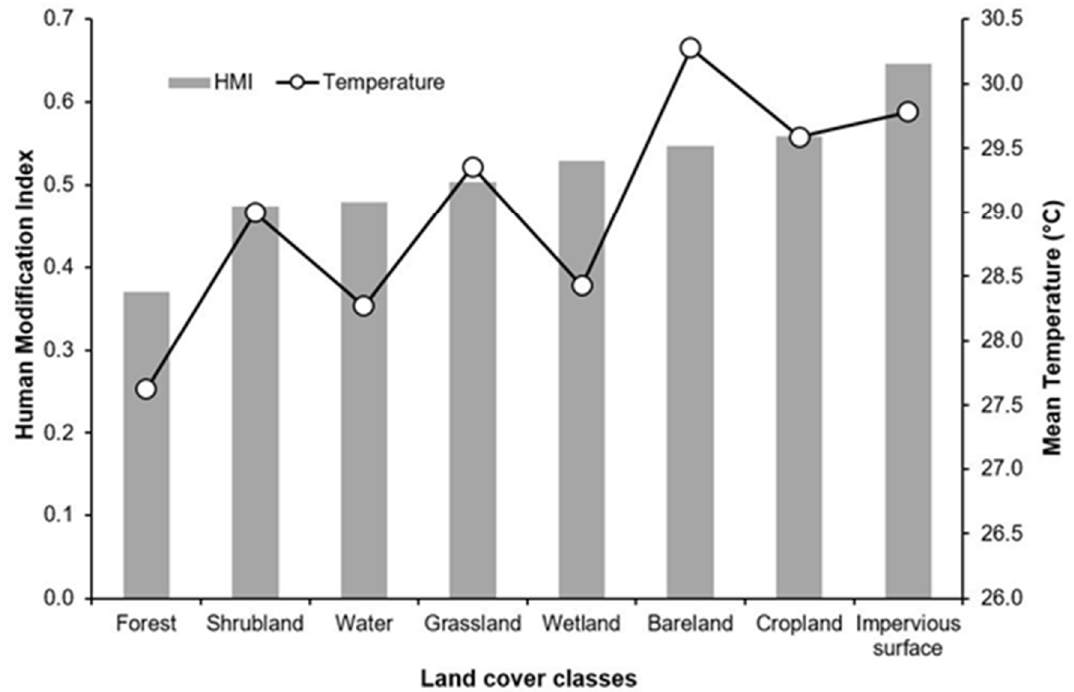
Figure 9. Variation of human modification index and mean land surface temperatures by land cover classes.